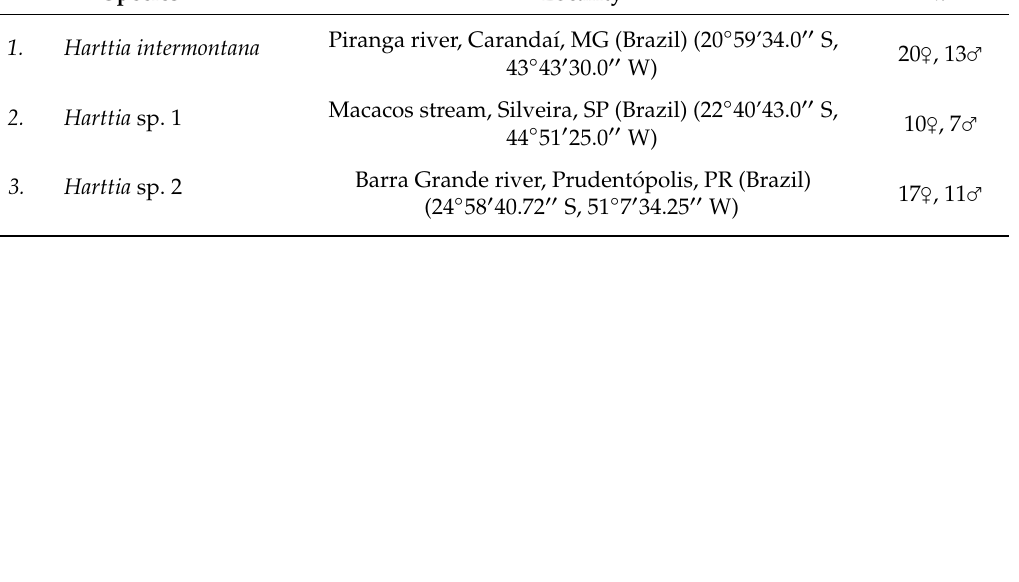
Table 2. Collection sites, sample sizes ( n ), and sex of the Harttia species analyzed.